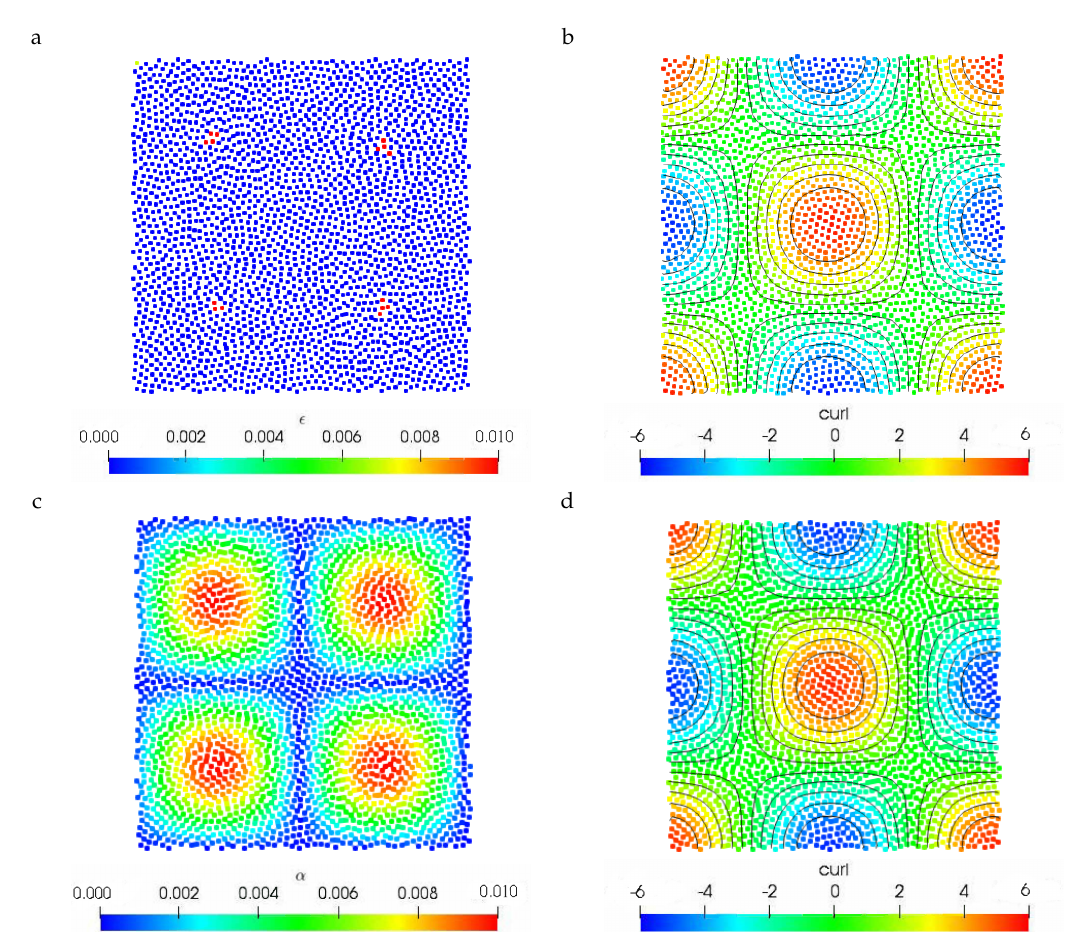
Figure 1. Two-dimensional Taylor–Green flow at Re = 100. On the top the viscosity parameter ( (cid:101) ) ( a ) and the vorticity field ( b ) obtained with the proposed δ -ADA-SPH scheme. On the bottom we show the value of the α parameter ( c ) and the vorticity field ( d ) using the δ -LES-SPH scheme. Results obtained at t =